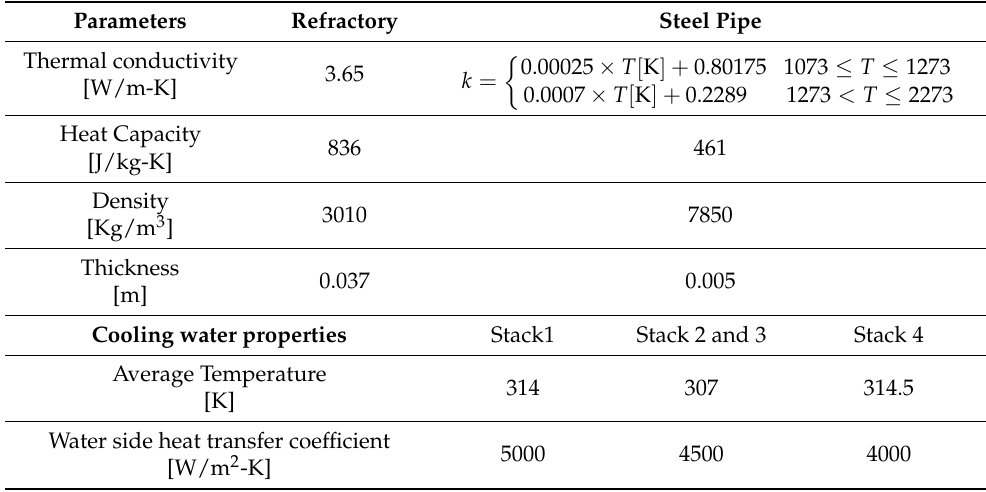
Table 3. Wall material and cooling water heat transfer properties for shell conduction modelling.